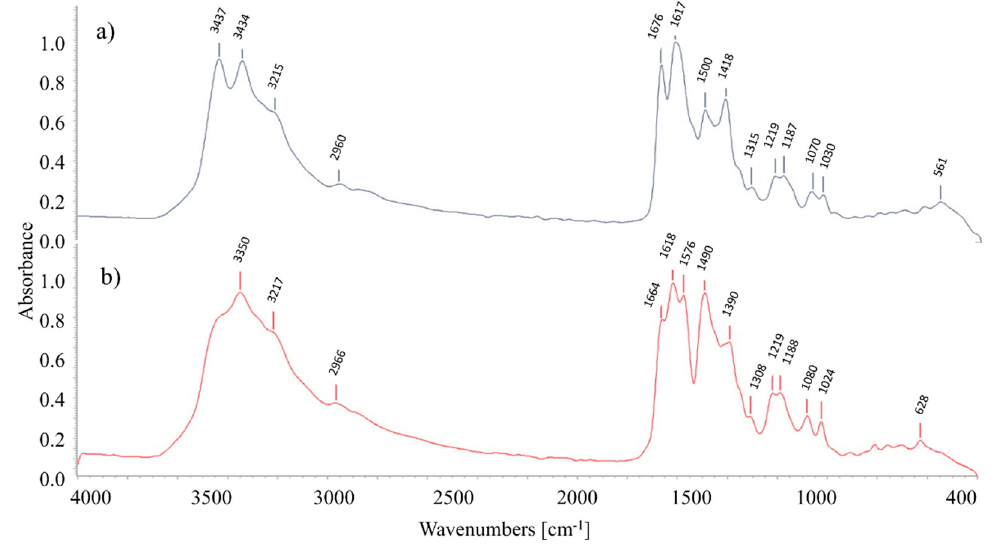
Figure 2. ( a ) FTIR spectrum of BHA; ( b ) FTIR spectrum of L-PC.